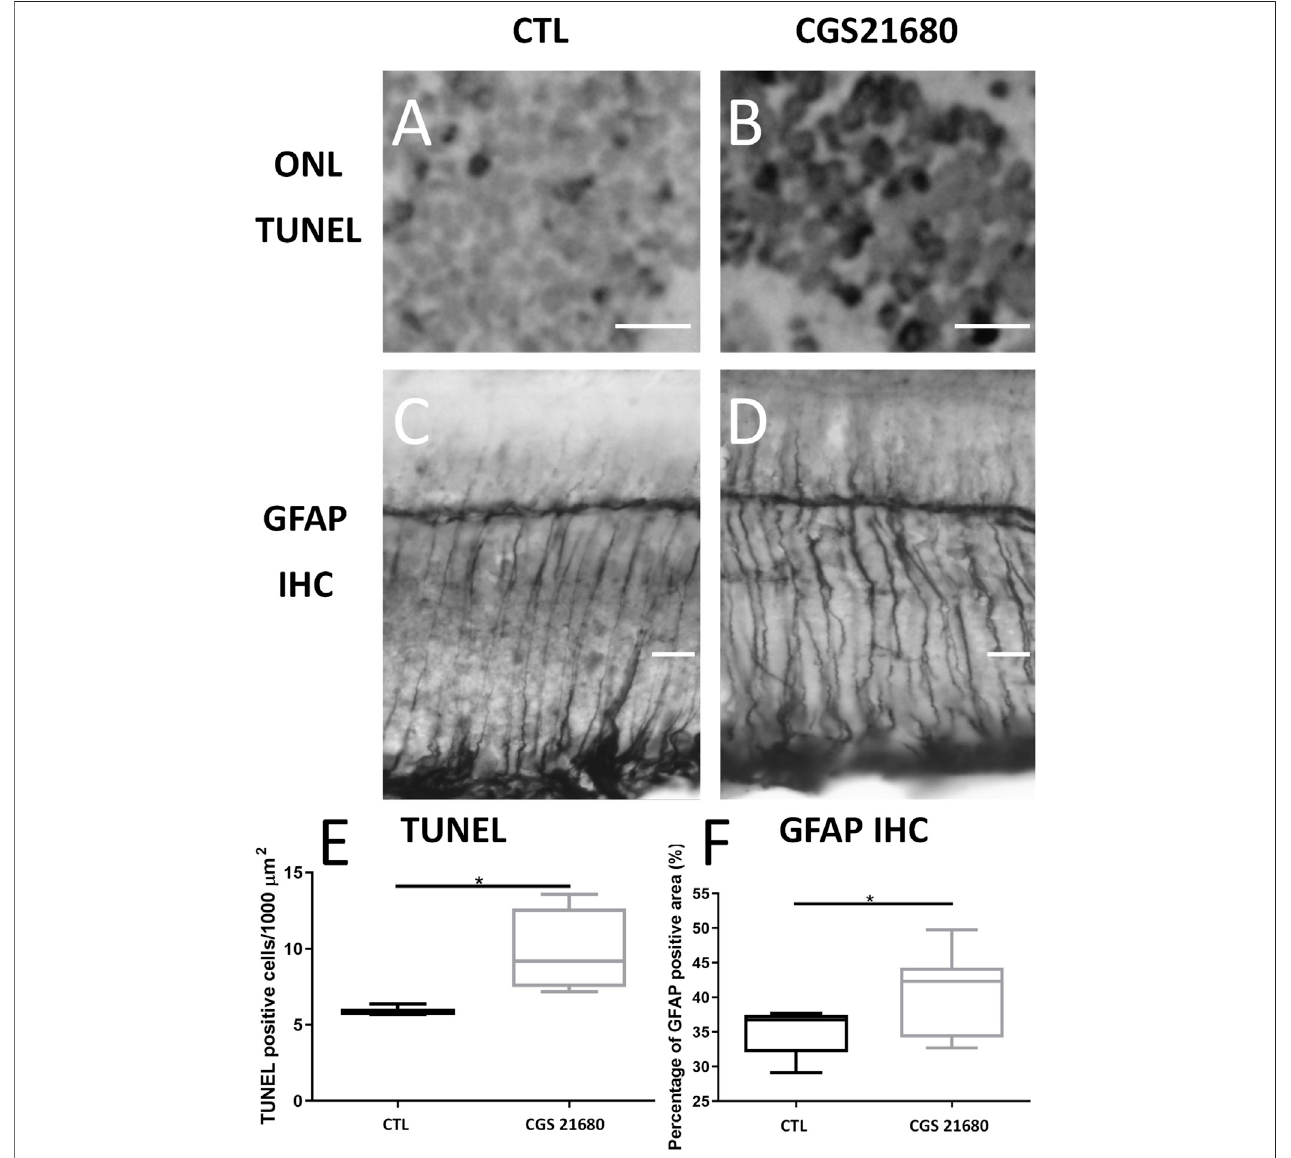
FIGURE 1 | Treatment with CGS21680 increased number of apoptotic nuclei and GFAP immunoreactive areas. (A,B) Representative sections showing TUNEL staining of ONL of retina of a CTL eye (A) and a CGS21680-treated eye (B) . Scale bar: 20 μ m. (C,D) : GFAP-immunostained sections from retina of a CTL eye (C) and a CGS21680-treatedeye (D) .MoreintenseGFAPimmunoreactivityofMüllercellsisobservedinretinaofCGS21680-treatedeyecomparedwithCTL. (E) Quanti fi cationof ONLTUNEL-positivecells.CGS21680producedasigni fi cantincreaseinpositivenucleiofONLcompared withCTL(Student ’ s t -test,* p < 0.05). (F) .Quanti fi cation of GFAP immunoreactive area. Boxes represent 25 and 75 percentiles, whiskers represent minimum and maximum values, and transverse lines represent medians. CGS21680 produced a signi fi cant increase in expression of GFAP compared with CTL (Student ’ s t -test, * p < 0.05).